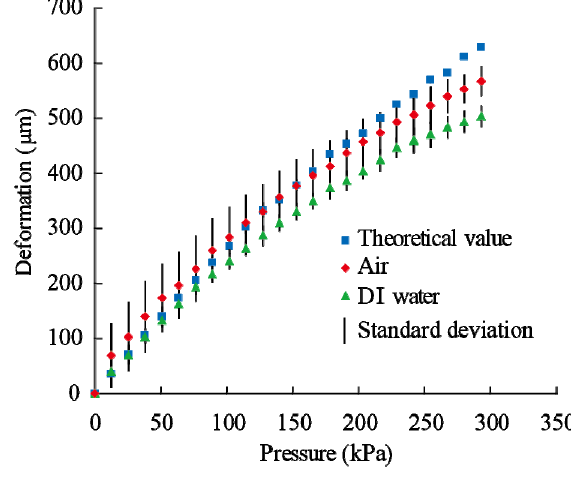
Figure 7. Calculated and experimentally deduced deformation of the device with and without DI water as a function of the applied pressure. The error bars represent standard deviation of the results ( N =